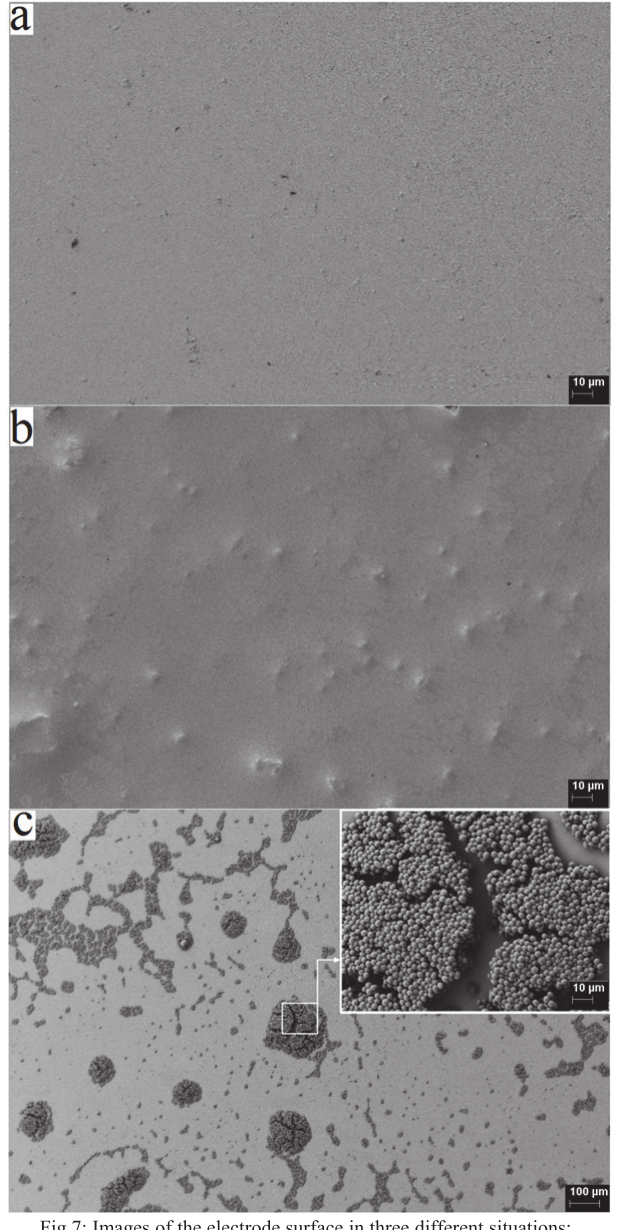
Fig.7: Images of the electrode surface in three different situations: (a) naked electrode, (b) after a measurement in which supernatant S1 was added and (c) after a measurement in which YW was added.